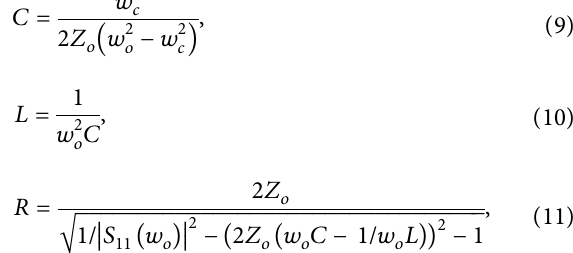
− 10 dB bandwidth keeps increasing as L increases as shown width of the upper band resonance.